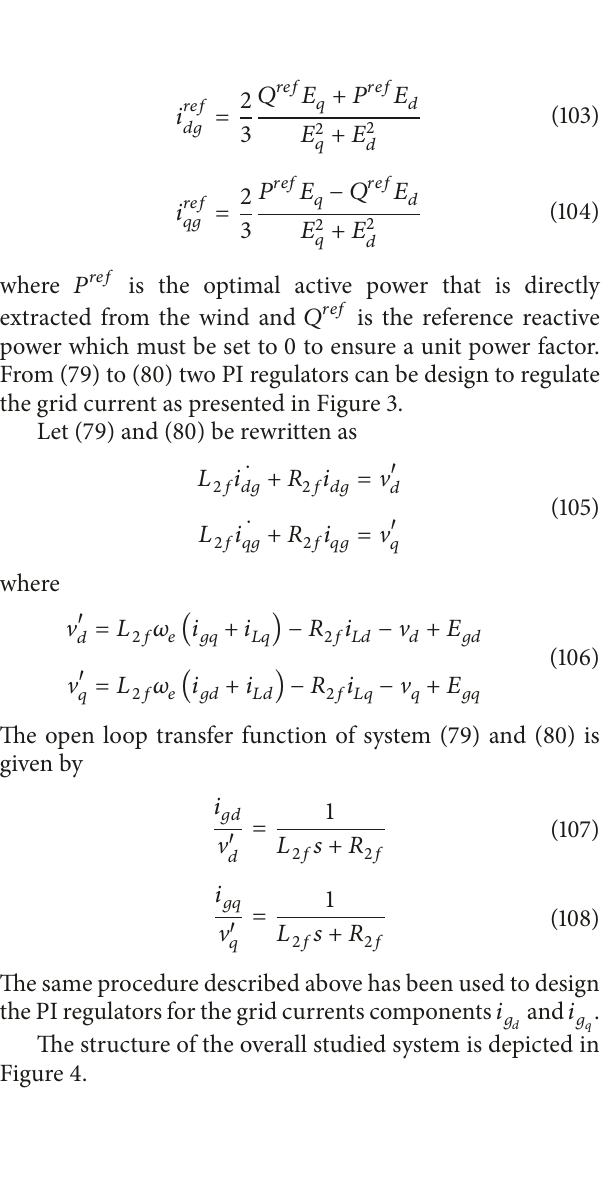
Figure 8: Performances of the inverter side PI controllers in stand-alone mode. Load phase voltage component (i), load phase current component (ii), and inverter control signal